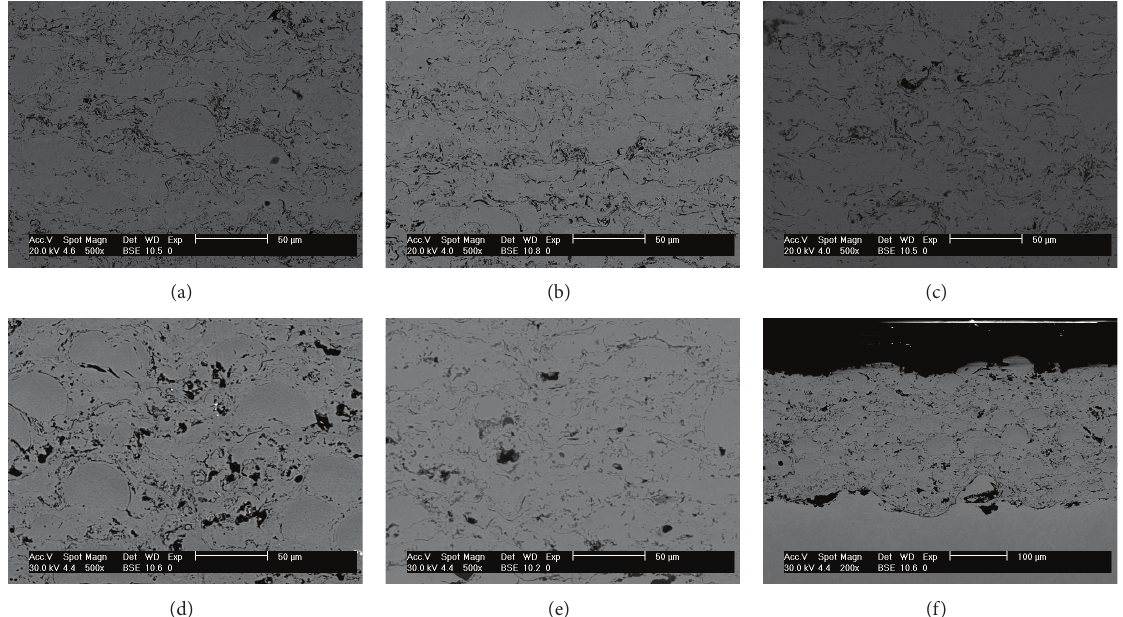
Figure 4: Co 32 Ni 21 Cr 8 Al 0.5 Y coating microstructure of a cross-section of different spray distances: (a) 203 mm, (b) 229 mm, (c) 254 mm, (d) 279 mm, (e) 305 mm, and (f) contaminants particles.